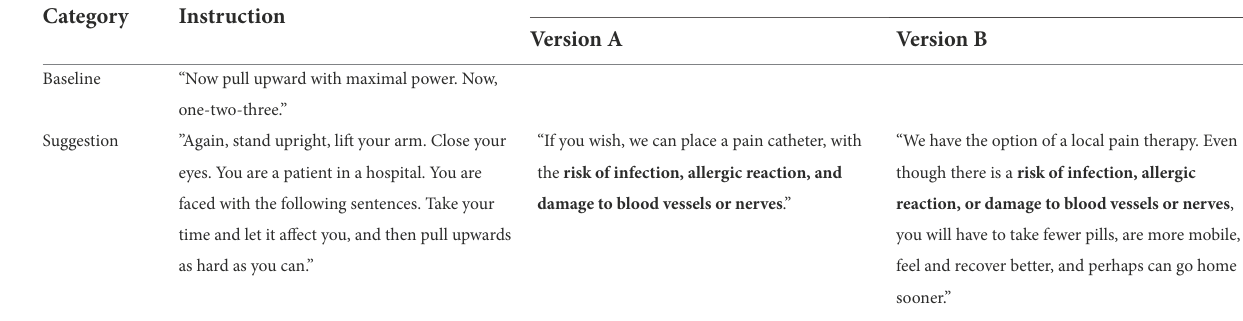
TABLE 1 Wording of the standardized instructions and verbal